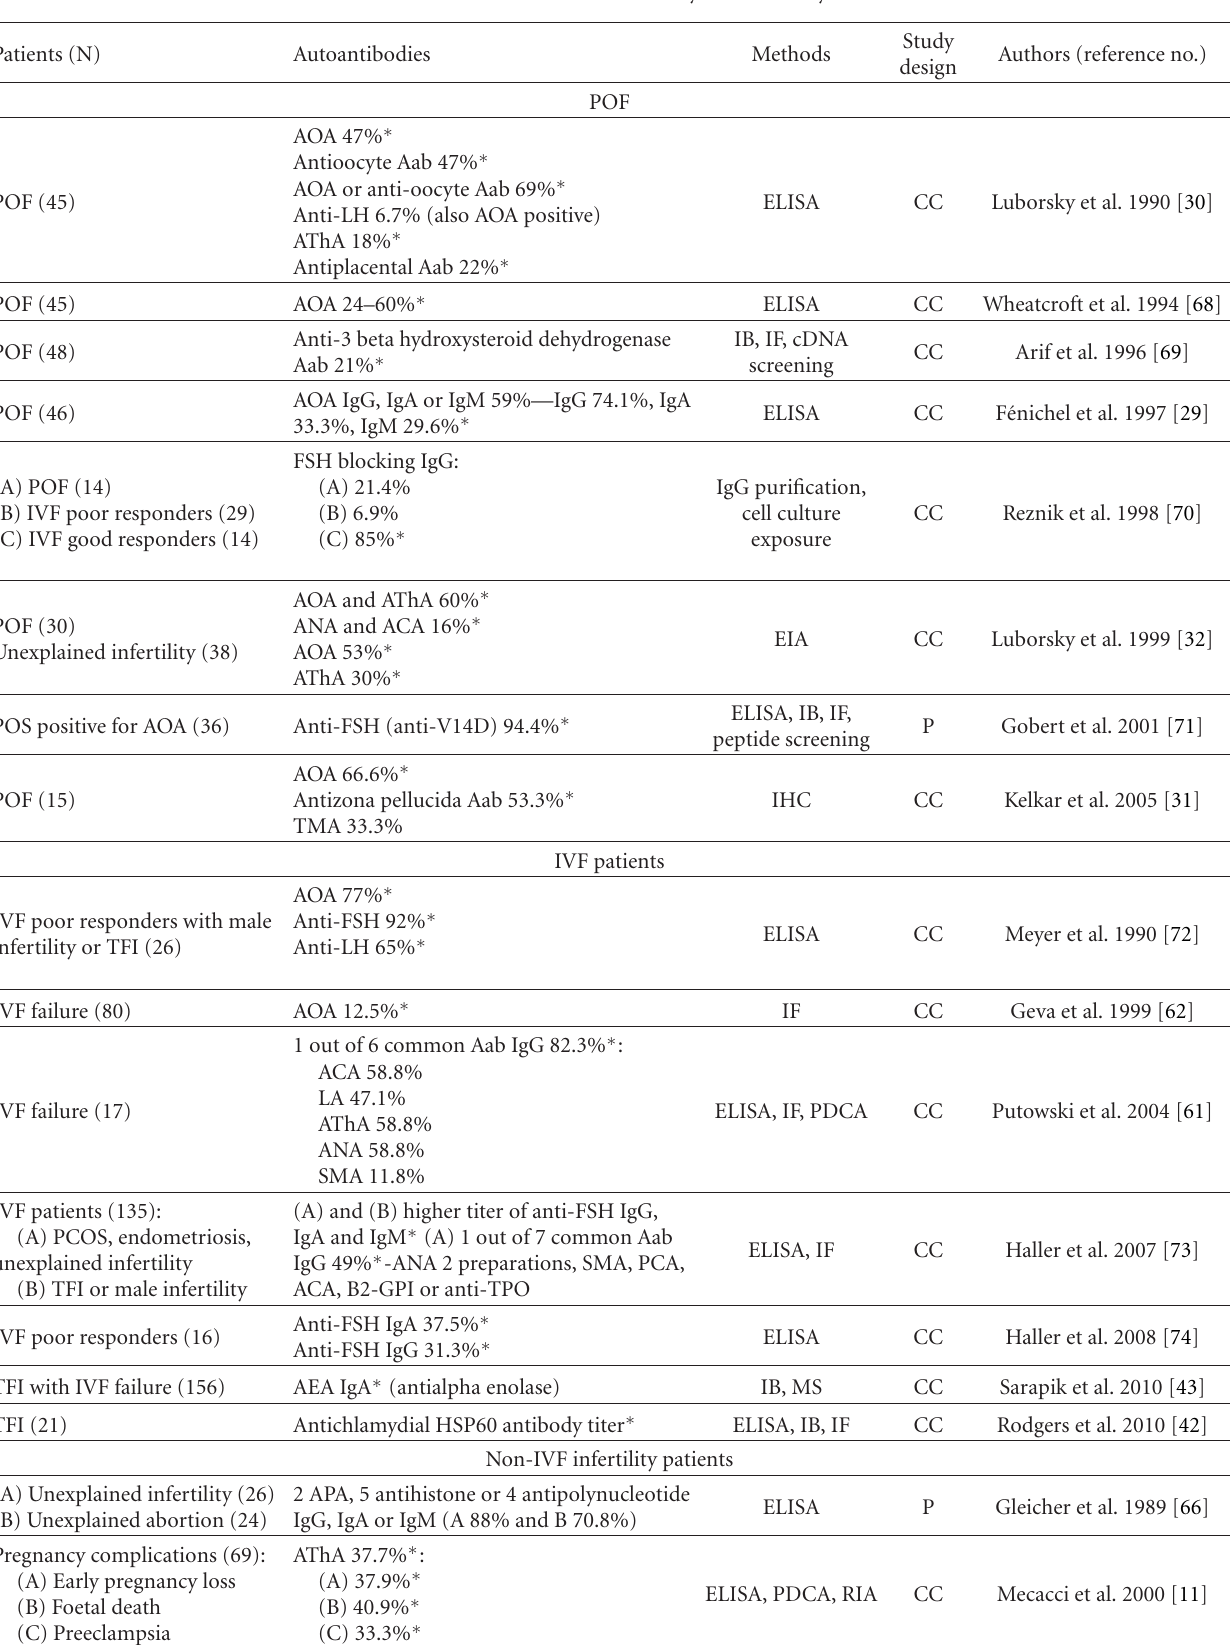
Table 2: Serum autoantibodies in female infertility and infertility-related diseases. Patients